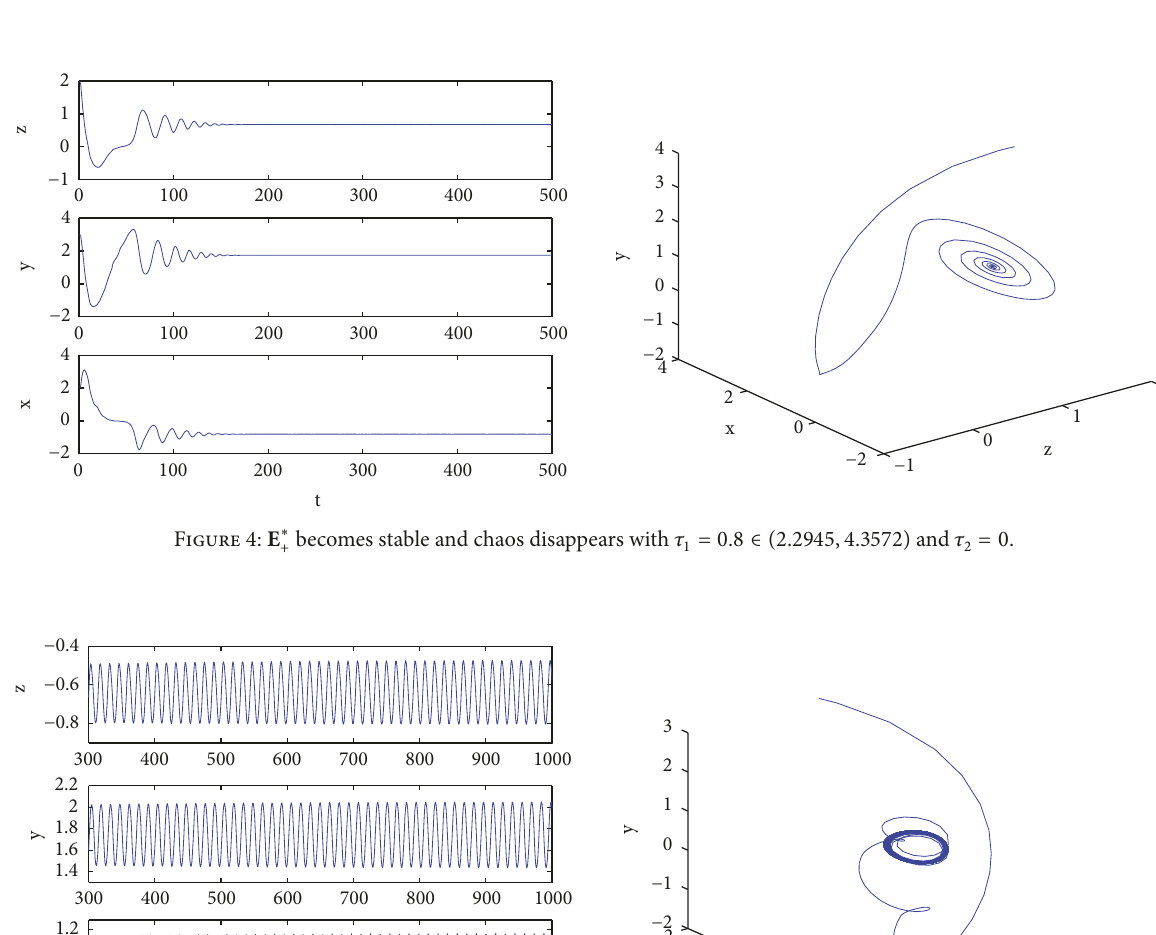
Figure 3: E ∗ + is unstable and chaos still exists with 𝜏 1 = 0.1 ∈ [0,0.3795) and 𝜏 2 = 0 .